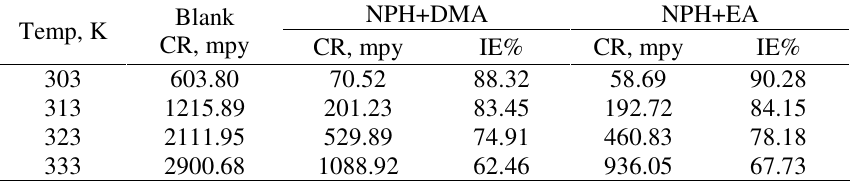
Table 3. Corrosion parameters in absence and presence of inhibitors at different temperatures